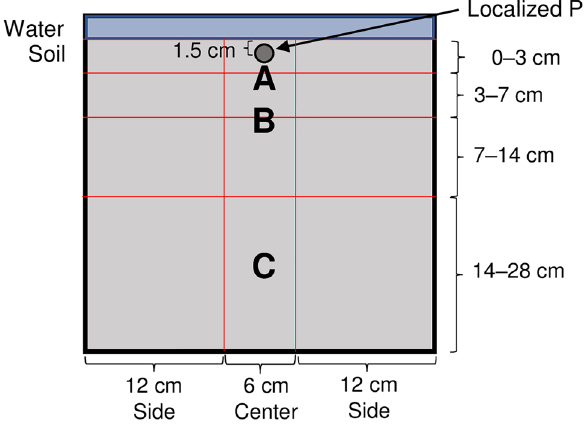
Figure 5. Schematic representation of the root box (30 cm × 30 cm × 3 cm) with the sampling points of soil water solution. Ceramic Rhizon samplers were installed in the middle of the box at ( A ) 3 cm, ( B ) 7 cm, and ( C )